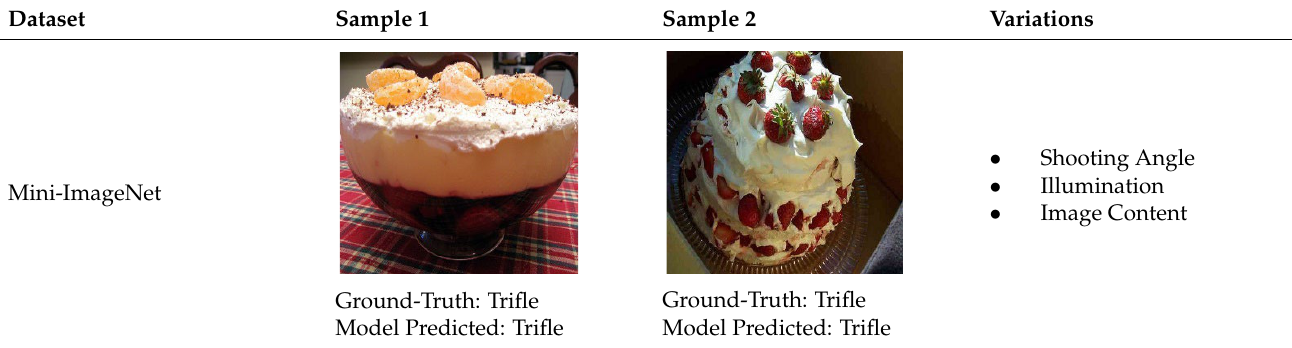
Table 7. Case studies on model robustness.